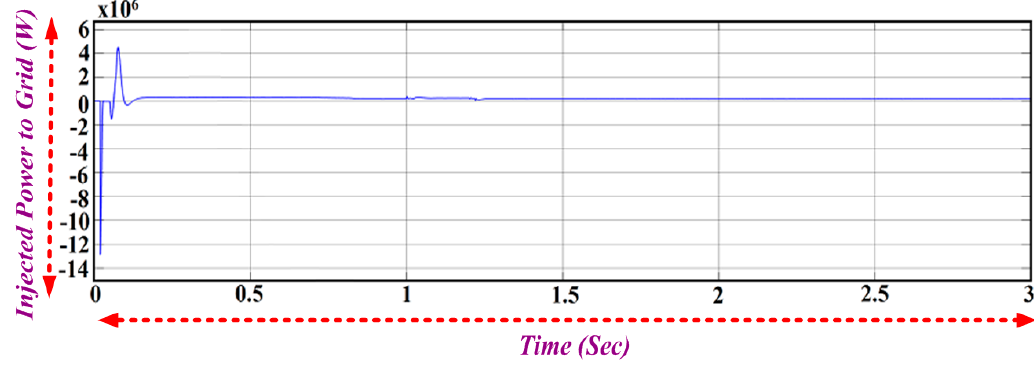
Figure 19. Power injected into the Grid.